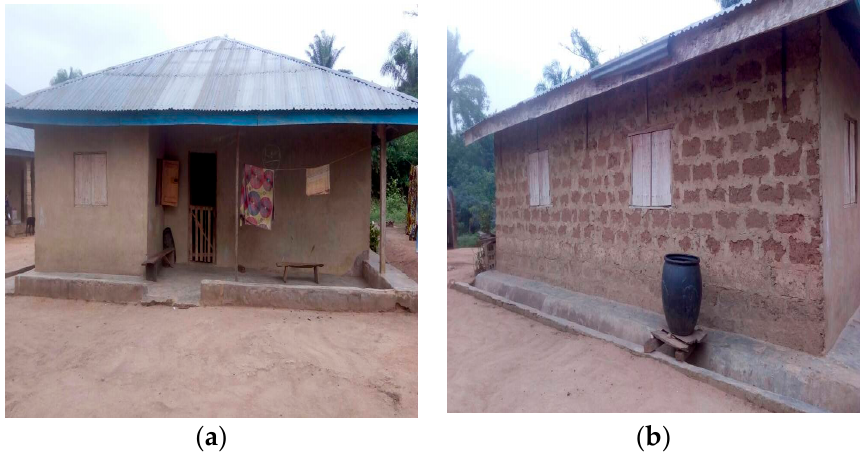
Figure 2. The dwelling ( a ) The front view of a house in Ala Ajagbusi; ( b ) the side view of a house in Ala Ajagbusi.